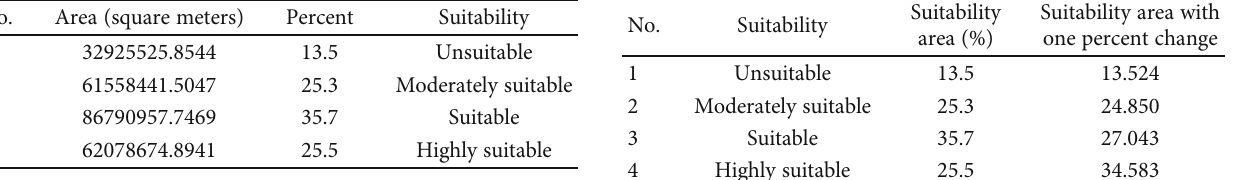
Table 15: Study area solar suitability in percent. No.